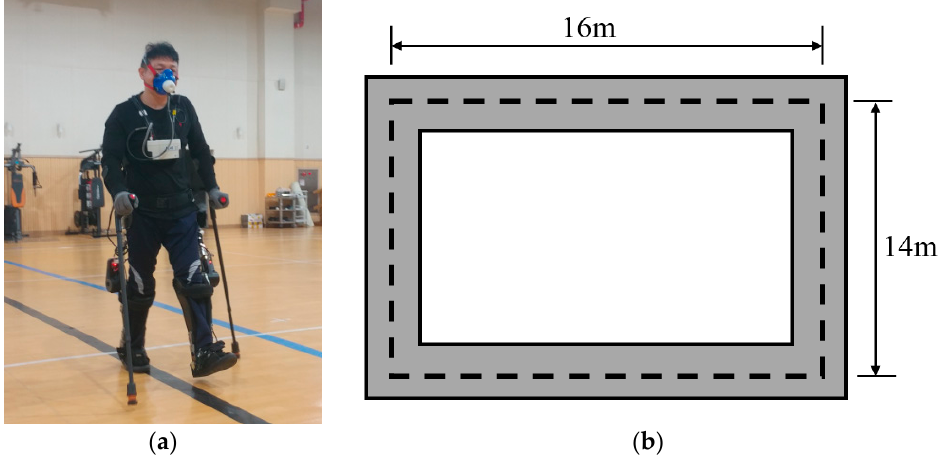
Figure 9. The 6 min walking test to compare the metabolic cost between EGO and KAEGO. ( a ) Walking test for measuring the subject’s oxygen consumption VO 2 and heart rate using K4b 2 , and ( b ) 60 m track used for the walking test.